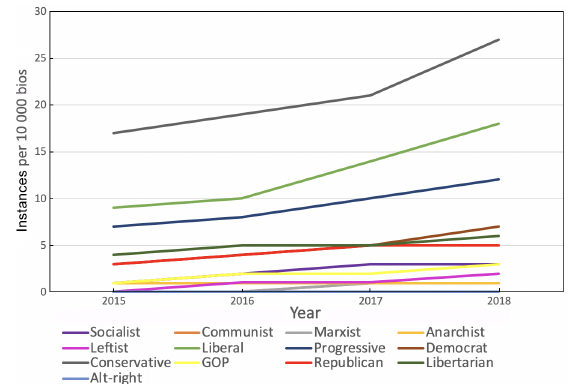
Fig. 5 Prevalence of “explicit polities” bio keywords, by year—cross-sectional